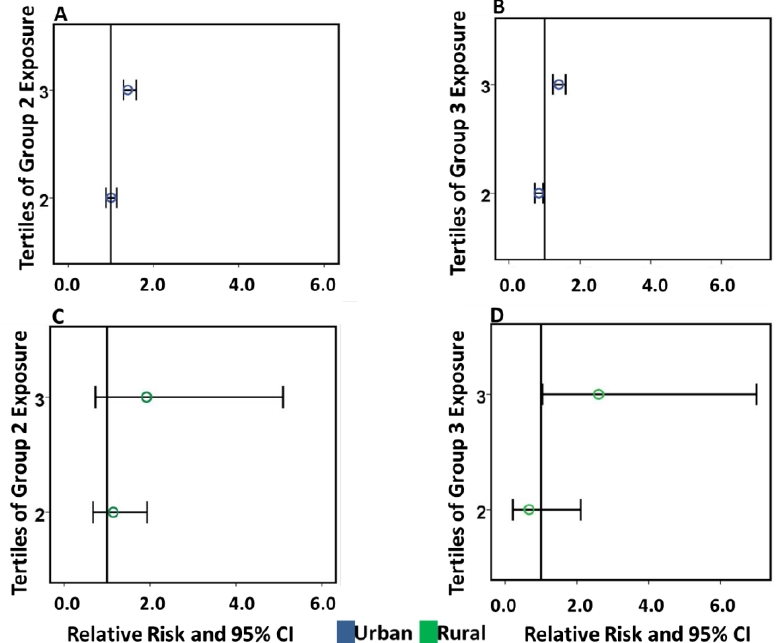
Figure 4. Adjusted relative risk of postal codes exposed to Group 2 and 3 emissions on CHD in urban and rural regions. ( A , B ) show increased risk ratio in the 3rd tertile with the highest exposure to Group 2 and 3 in urban postal codes. Group 3 also showed a significant inverse association in the 2nd tertile of exposure. ( C ) Shows the rural postal codes exposed to Group 2 emissions with no effect which may have been related to the small sample size. ( D ) Shows increased risk ratio (RR) of exposure to Group 3 in the 3rd tertile in rural postal codes.